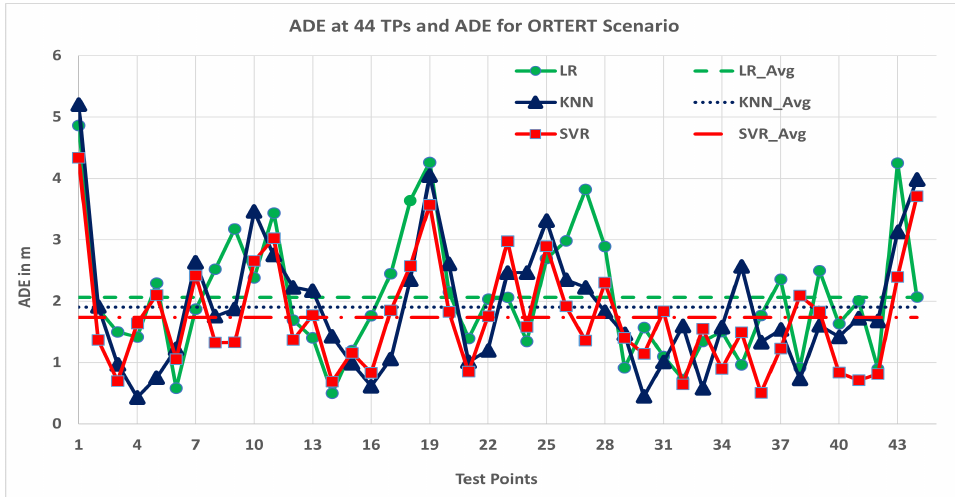
Figure 9. ADE at 44 TPs and ADE for ORTERT scenario.